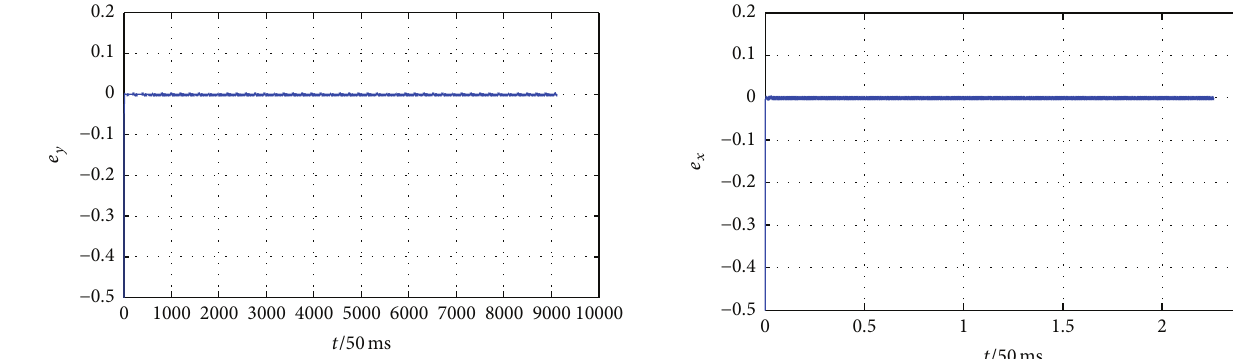
Figure 12: The curve 𝑒 𝑥 for single variable feedback system.